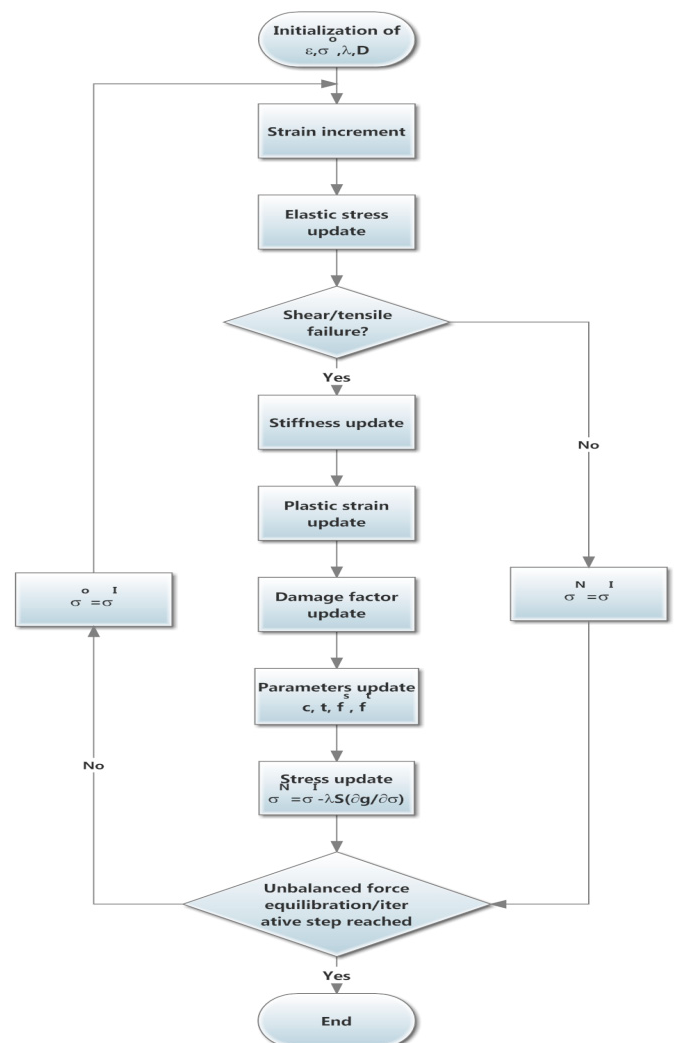
Figure 5. Computational scheme for numerical implementation of the EPD model into FLAC3D.